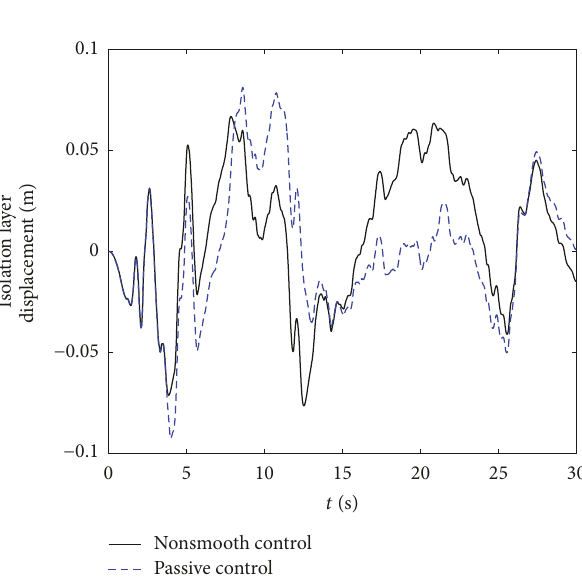
Figure 8: Velocity response of isolation layer.